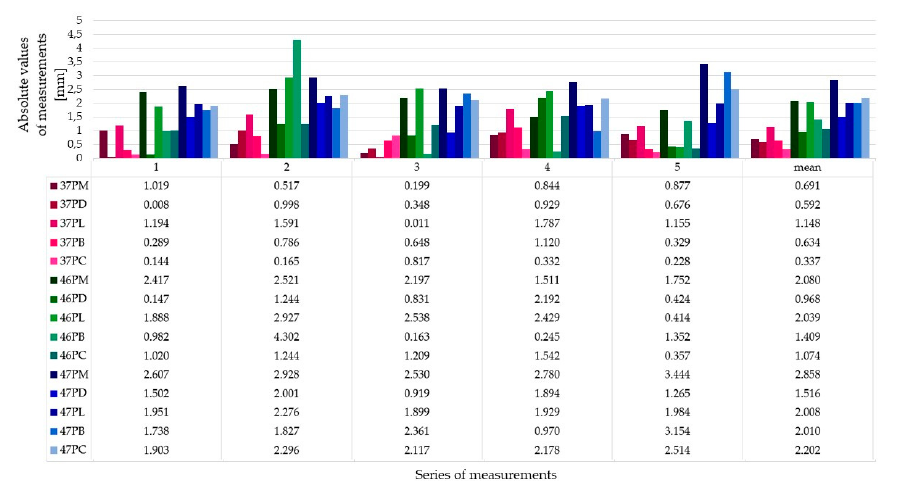
Figure 3. Absolute values of measurements which were done on each of five measurements points on each insert in positions 37, 46 and 4. Name of measurement point: tooth number and